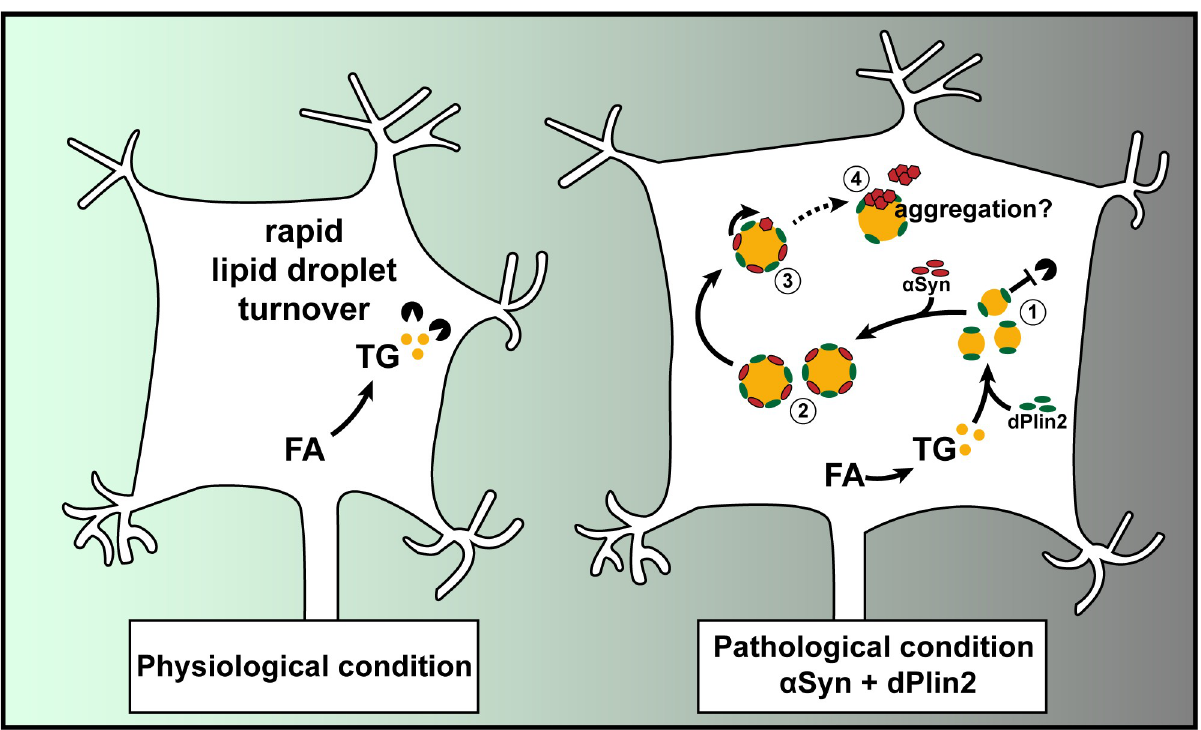
Fig 7. Model of the reciprocal interactions between α Syn and LDs in PD. Under normal physiological conditions, neurons contain relatively few LDs. We propose the following scenario under pathological conditions associated with elevated levels of α Syn and dPlin2: (1) increased dPlin2 limits the action of neuronal lipases and promotes LD accumulation; (2) α Syn binds to the expanding dPlin2-positive LDs, which further increases LD accumulation; (3) α Syn is converted to a proteinase K-resistant form(s) on the surface of LDs; and (4) the aberrant form of α Syn may aggregate at the surface of or in close proximity to LDs, leading to formation of cytoplasmic inclusion bodies